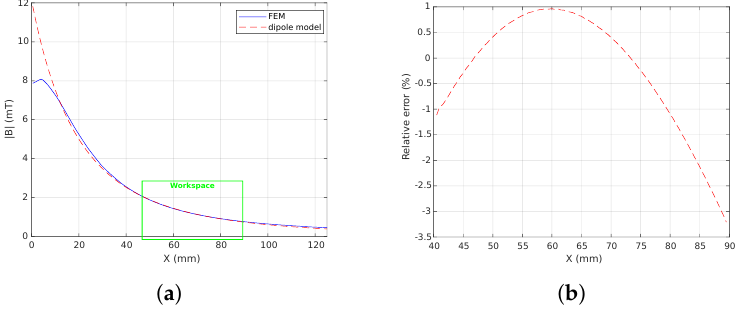
Figure 11. Comparison of simulation results for the FEM and point-dipole model along the x axis: ( a ) the magnetic field magnitude where the green box delimits the range of workspace, and ( b ) the relative error within the